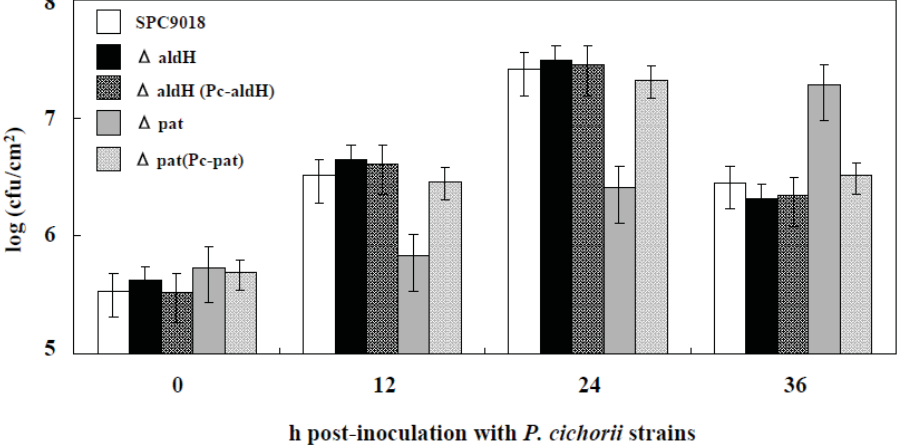
Figure 3. Population dynamics of P. cichorii strains in infiltrated eggplant leaves. Values represent the mean ± standard deviation (SD) of five separate experiments. Populations of ΔaldH, ΔaldH(Pc - aldH) and Δpat(Pc -pat) were not significantly different from the population of P. cichorii strain SPC9018 (P < 0.05) by the Student’s t -test.